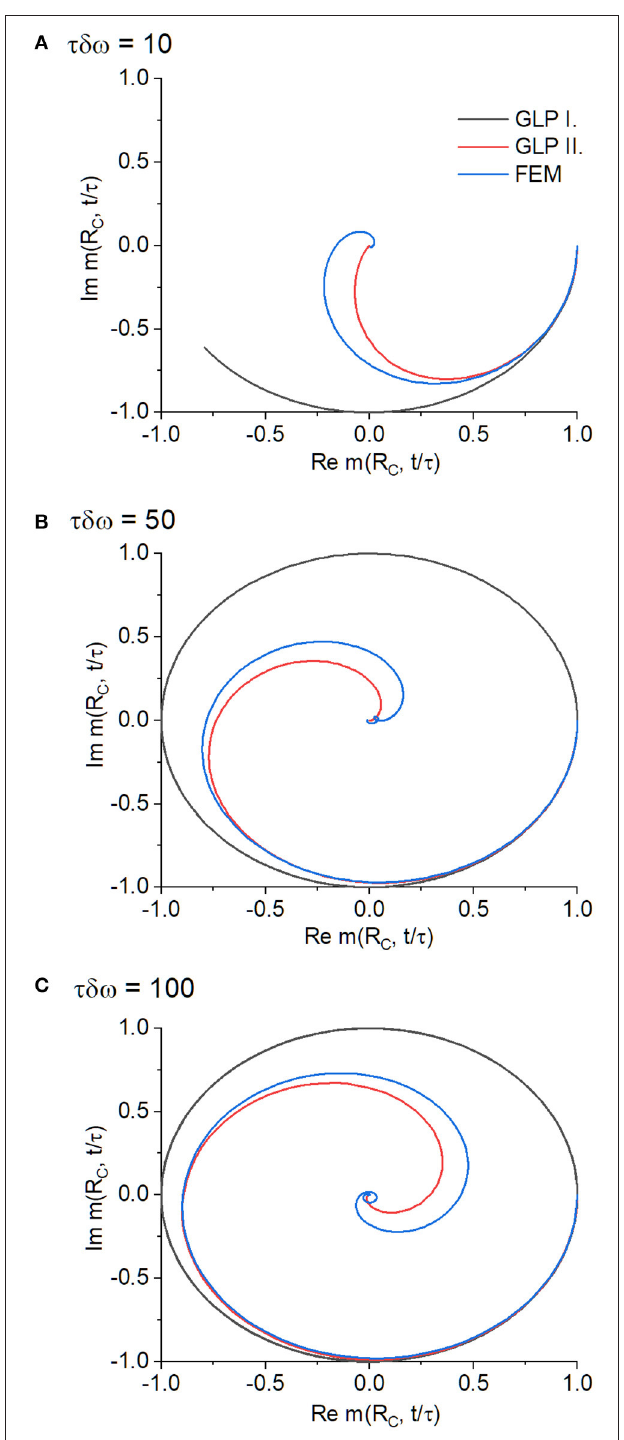
FIGURE 5 | Visualization of the real part and the imaginary part of the local magnetization at R C and φ 0 for τδω 10 (A) , τδω 50 (B) , and = = = τδω 100 (C) with η 0.1. The starting point lies at Re( m ( R C ,0)) 1, = = = Im( m ( R C ,0)) 0 for each graph. The oscillatory nature of the local = magnetization in the GLP first order can be clearly